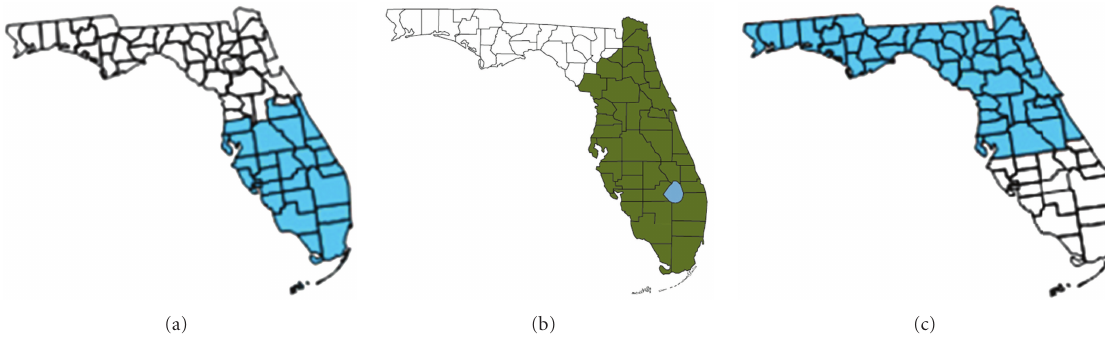
Figure 6: Planting regions in Florida for C. torelliana (a), E. grandis (b), and E. amplifolia (c).